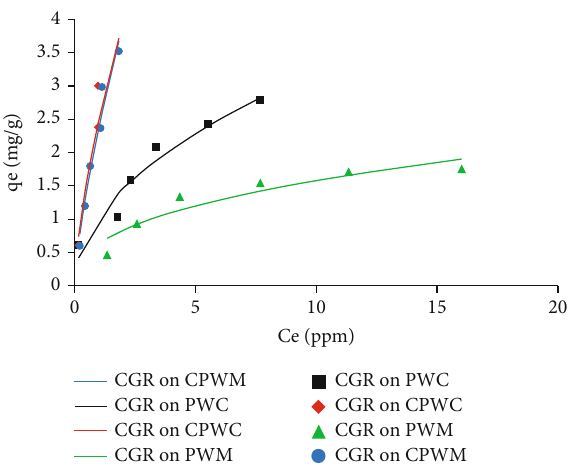
Figure 15: Nonlinear Freundlich isothermal investigation.